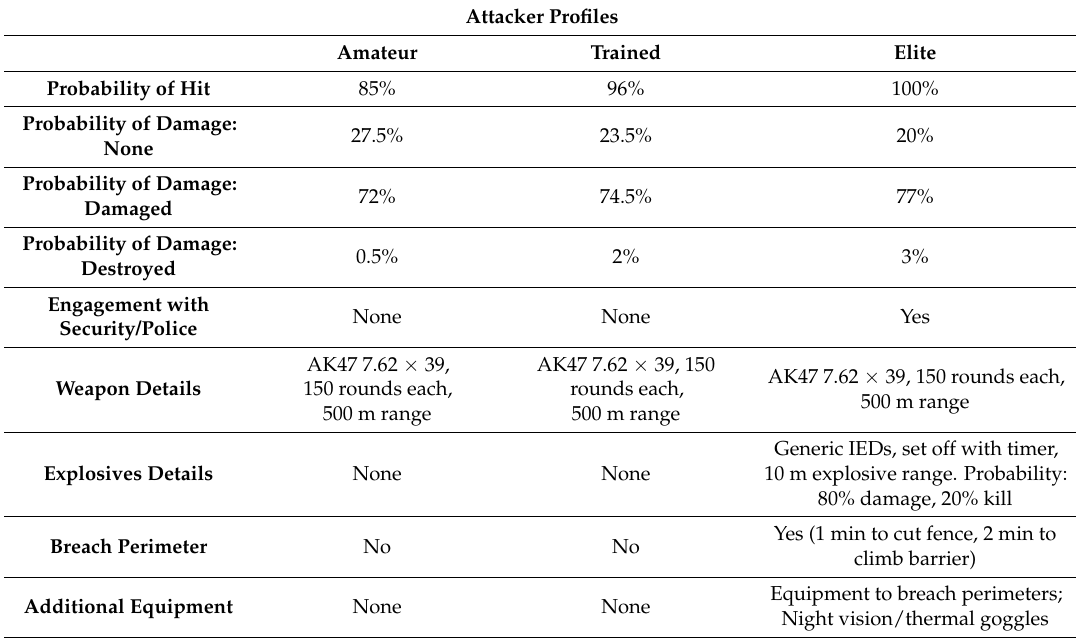
Table 2. Attacker Profiles,